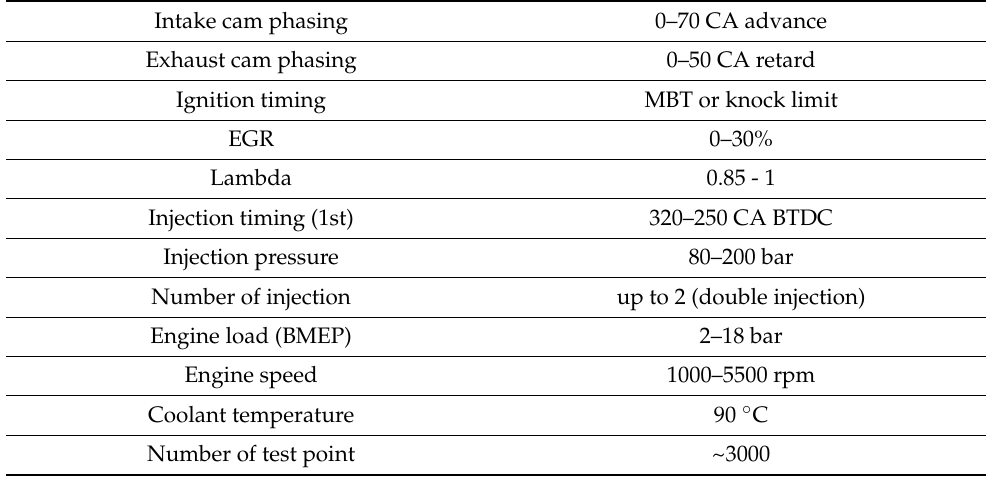
Table 3. Test condition and parameters.